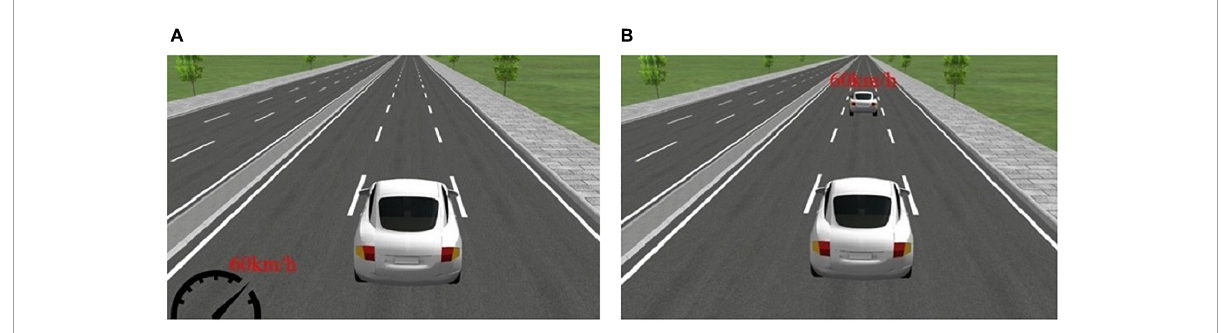
FIGURE2 Scenarios for the fatigued driving experiment. (A) The free-driving fatigued driving scenario and (B) car-following fatigued driving scenario are shown.